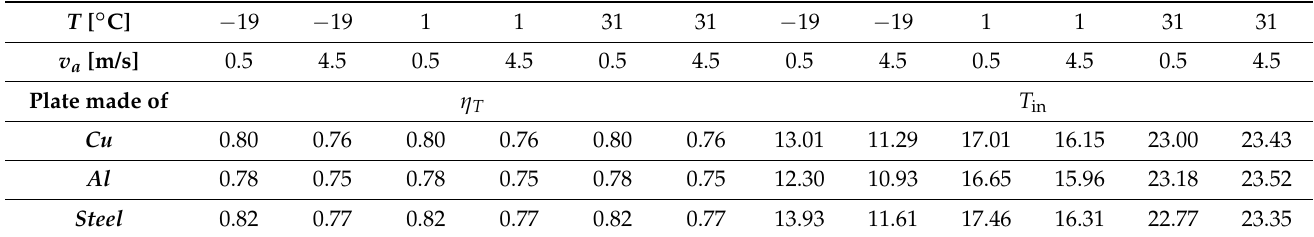
Table 15. Comparison of the efficiency of plates of the thickness h = 0.0012 m made of copper, aluminium, and steel for an air exchange duration of t end = 300 s, and air velocities of v a = 0.5 m/s and v a = 4.5